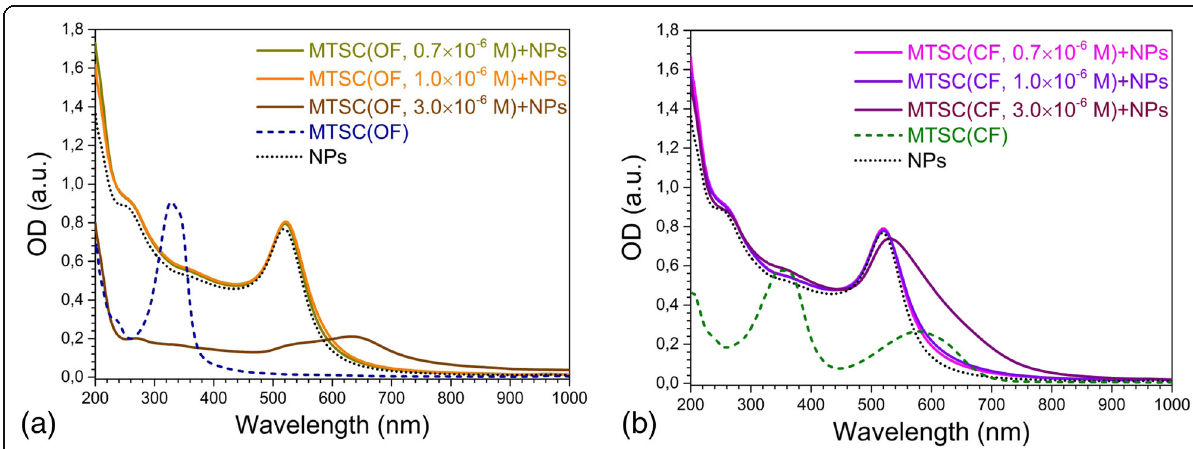
Fig. 4 Changes in absorption spectra of gold nanoparticles influenced by C5F-MTSC in OF ( a ) and CF ( b ). The volume ratio of water to ethanol was equal to 5:1. The concentration of DAEs was C DAE = 0.7 × 10 − 6 , 1.0 × 10 − 6 , 3.0 × 10 − 6 M, but the control spectra C5F-MTSC in OF and CF was measured at C DAE = 10 − 5 M. The concentration of gold C Au = 2 × 10 − 4 M was constant for all